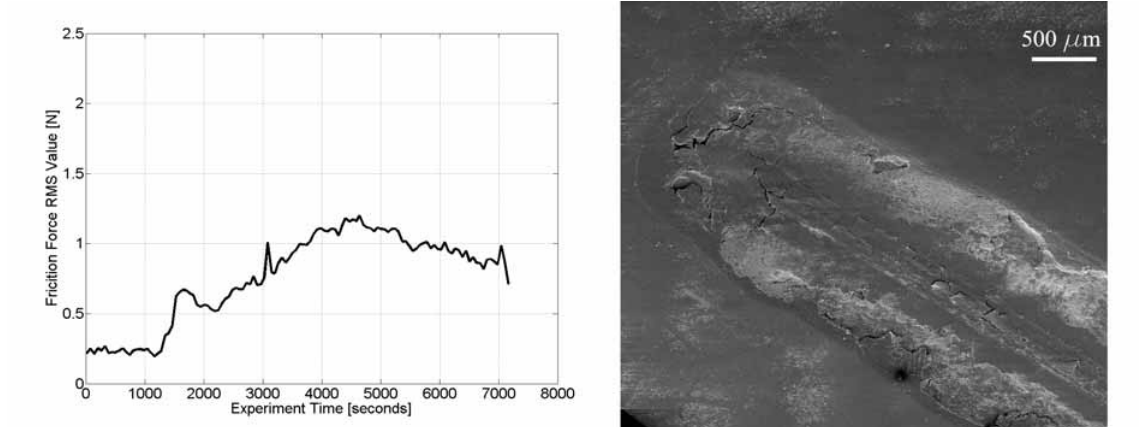
Fig. 16. Estimated friction force and surface SEM photography: Class II experiment.